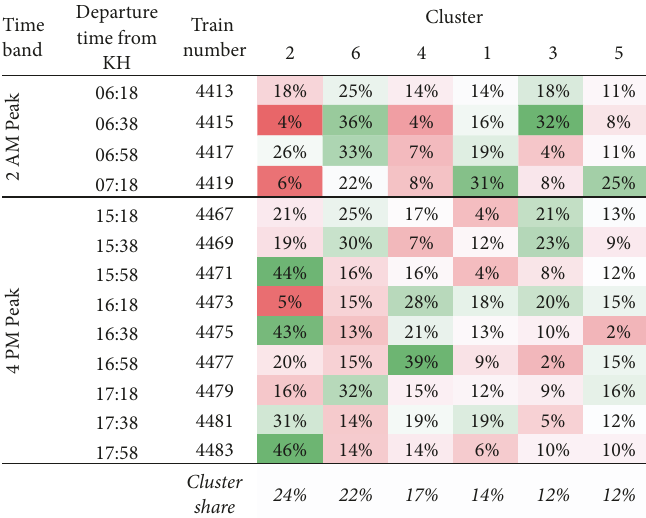
Figure 8: Northbound ØD trains. Cluster share by train service ID. The color code compares the individual row’s distributions among clusters to the overall distribution among clusters reported in the last row. Clusters sorted by size.